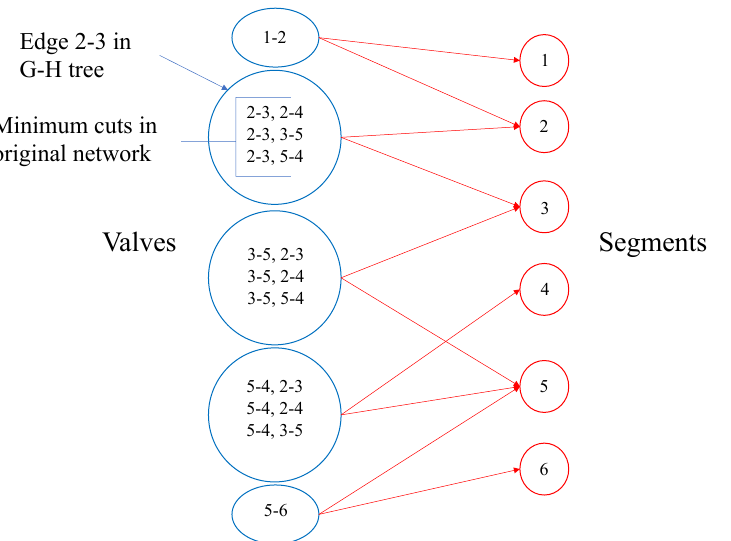
Figure 2. Representation of the logical network, where valves that were represented by edges are modeled as nodes and segments are also modeled as nodes, and the edges between valves and segments represent logical